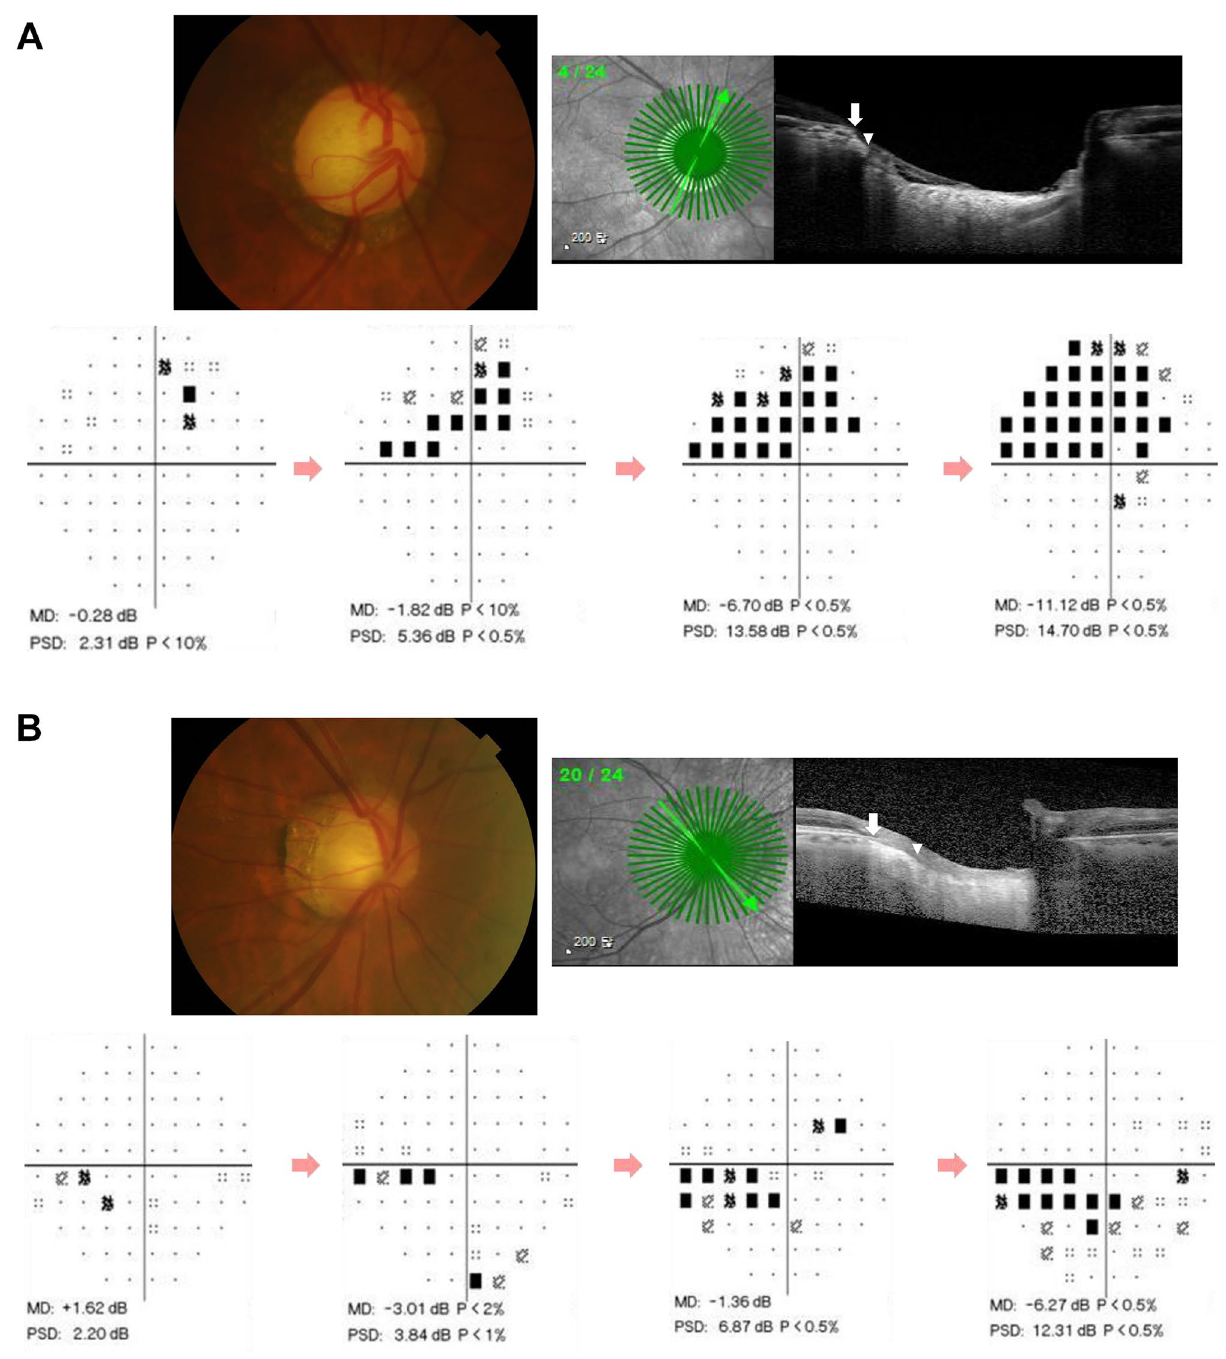
Figure 2. Representative cases showing the relationship between the direction of the maximum externally oblique border tissue (EOBT) and the location of glaucomatous damage. ( A ) Images from a 79-year-old man with primary open-angle glaucoma (spherical equivalent, – 0.75 diopters [D]; axial length, 23.03 mm). The location of the maximum EOBT was + 30°. Mean deviations (MD) on static automated perimetry C30-2 were – 6.30 decibels (dB) on the first exam in 2001 and – 11.12 dB with superior visual field progression on the last exam in 2018. ( B ) Images from a 60-year-old man with NTG with myopia (spherical equivalent, – 3.75 D; axial length, 25.97 mm). MDs were + 1.62 dB on the first exam in 2006 and – 6.27 dB with inferior visual field progression on the last exam in 2017. The location of the maximum EOBT was –